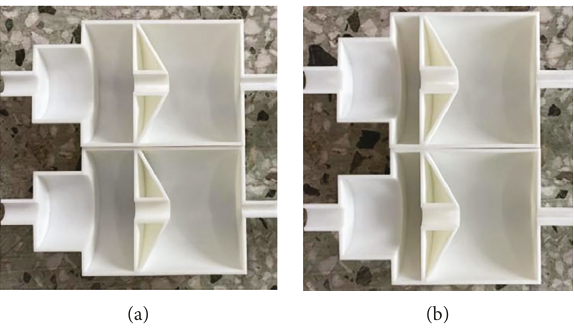
Figure 17: Cavitation nozzles. (a) D/a